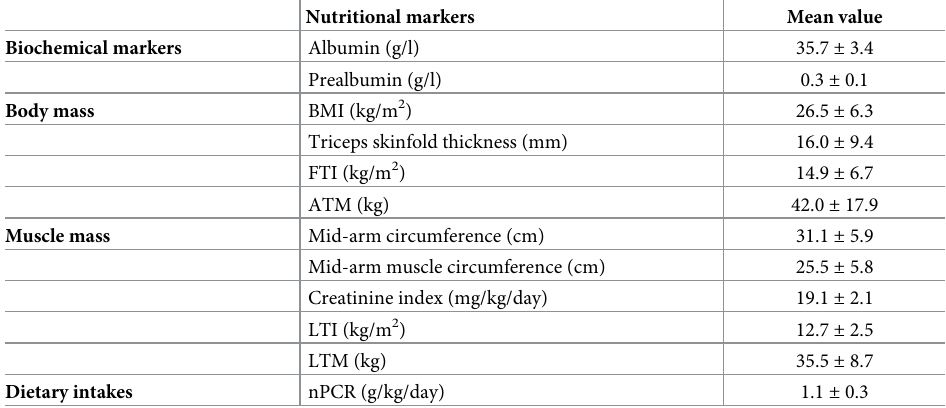
Table 2. Baseline values of nutritional